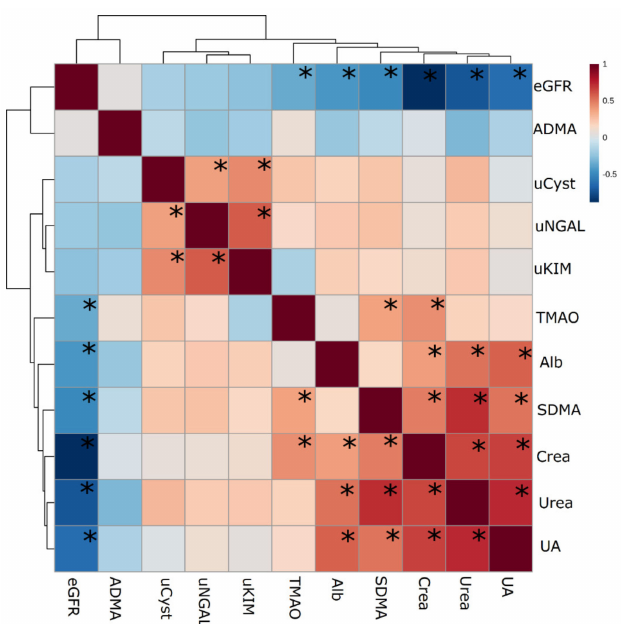
Figure 4. Correlations between the relative level of the toxins and other AKI biomarkers. * Significant correlations ( p < 0.05); Di ff erent colors indicate di ff erent Spearman correlation coe ffi cients (strength and direction of correlation) i.e., read color-positive correlation, blue-negative correlation; the darker the color the higher the strength of the relationship. Abbreviations: eGFR-estimated glomerular filtration rate, ADMA-asymmetric dimethylarginine, uCyst-urinary cystatine, uNGAL-urinary neutrophil gelatinase-associated lipocalin, uKIM-kidney injury molecule, TMAO-trimethylamine N-oxide, Alb-urine albumin, SDMA-symmetric dimethylarginine, Crea-creatinine, UA– uric